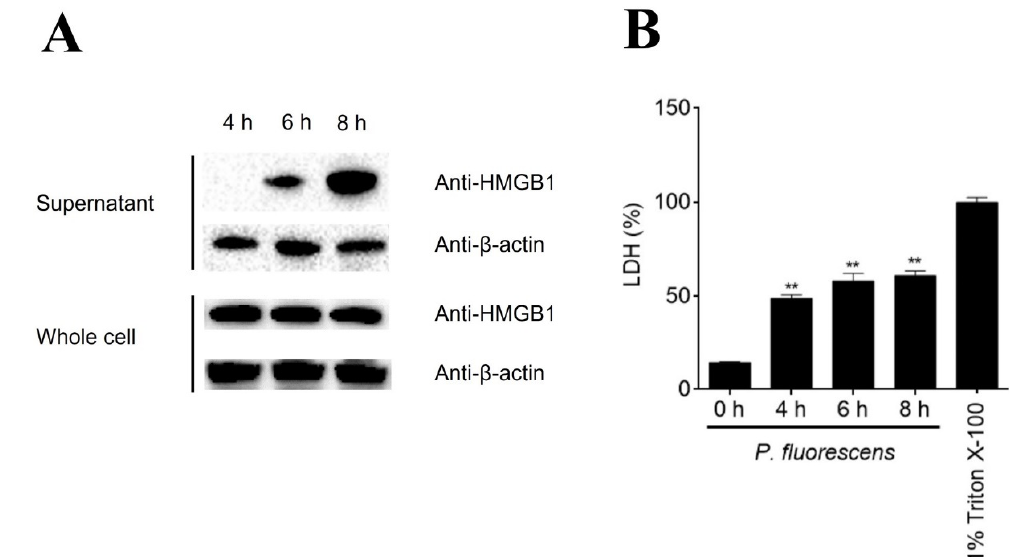
Figure 2. Detection of HMGB1 and LDH release from peripheral blood leukocytes during bacterial infection. ( A ) Flounder peripheral blood leukocytes (PBLs) were infected with Pseudomonas fluorescens . At 4, 6, and 8 h postinfection (hpi), HMGB1 in the whole cells and the culture supernatant were detected by immunoblotting. ( B ) PBLs were infected as above. At 0, 4, 6, and 8 hpi, LDH in the supernatant and whole cells was determined. PBLs lysed by 1% Triton X-100 were used as the maximum of LDH release. Values of triplicate experiments are shown as means ± SD. ** p < 0.01.